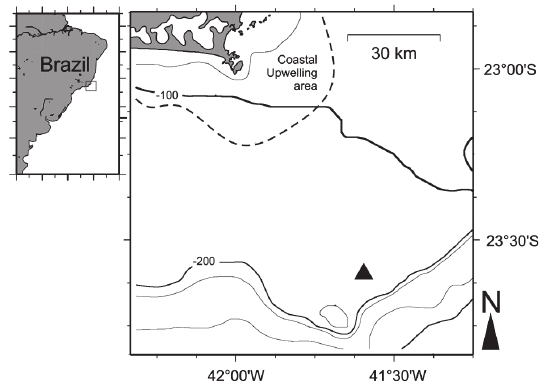
Figure 1 - Study area offshore from Cabo Frio on the south- eastern Brazilian Shelf. The mooring site is marked with a black triangle.